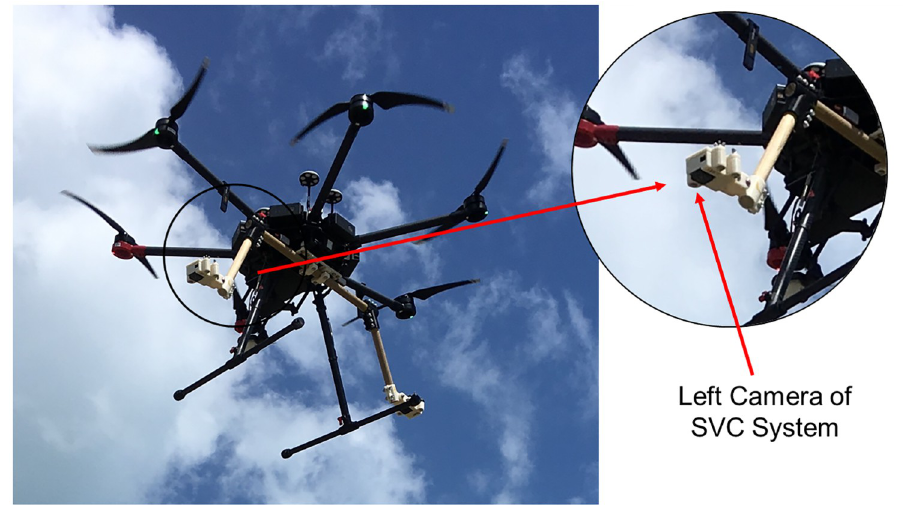
Fig 3. Unoccupied aerial vehicle in flight with stereo-video camera system mounted, and left camera highlighted.